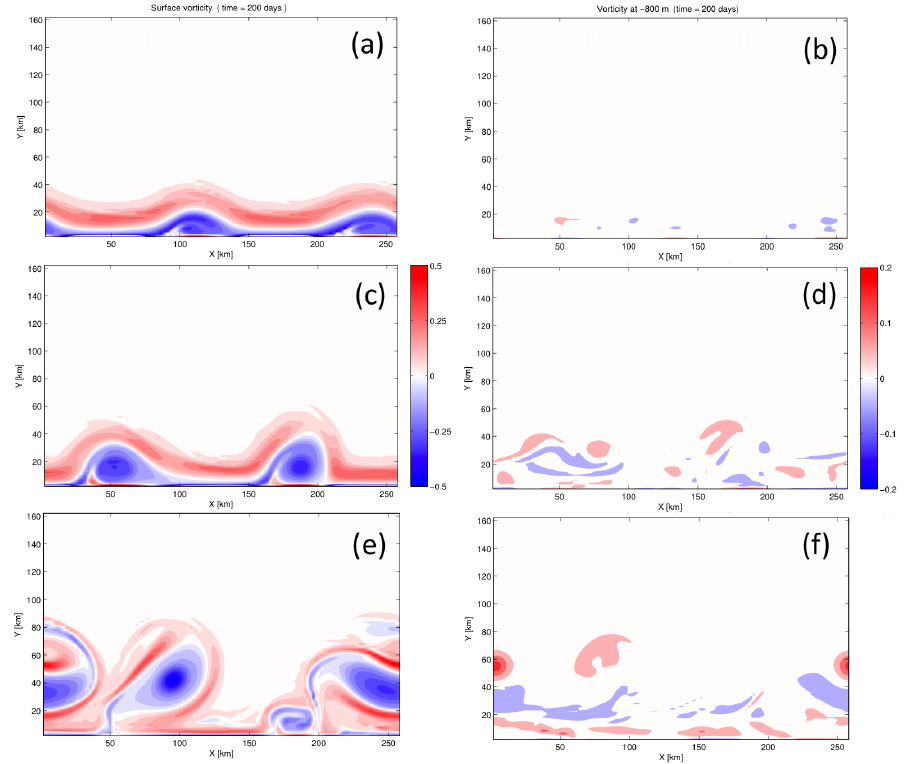
Figure 7. Same as Fig. 5, but for a shelf slope ( s = 6%, T p = − 0 . 34) when the aspect ratio parameter is γ (cid:39) 0 . 1 ( H = 3000m) and the vortex Rossby number is Ro = 0 . 25. Panels (a, b) , (c, d) , and (e, f) correspond to t = 200, t = 280, and t = 380 days,